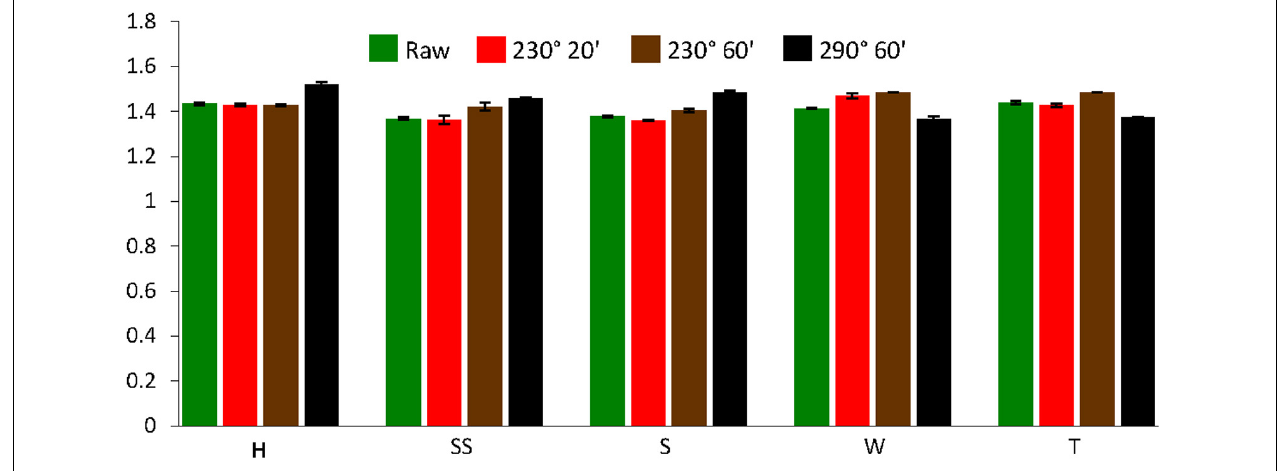
FIGURE 4 | True density of raw and torrefied biomass samples (H, hard almond shell; SS, semi-soft almond shell; S, soft almond shell; W, walnut shell; T, almond twig). Torrefying oven conditions were at temperature of 230 or 290 ◦ C and residence time of 20 or 60 min.